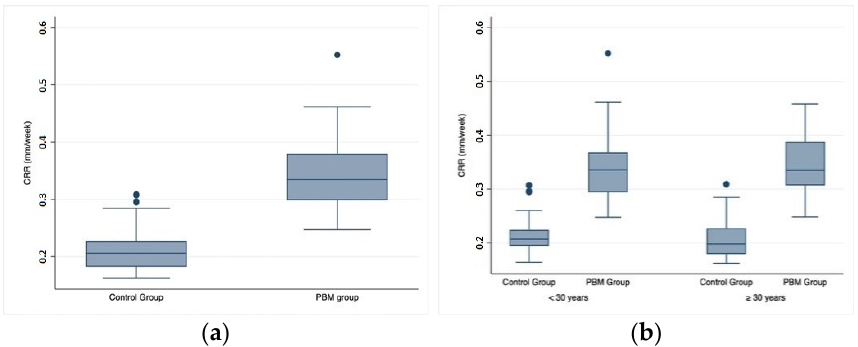
Figure 3 . Box Plot. ( a ) The alignment rate in control and PBM groups; ( b ) subgroup analysis by age range: the alignment rate in control and PBM groups related to age (age <30 years, age ≥ 30